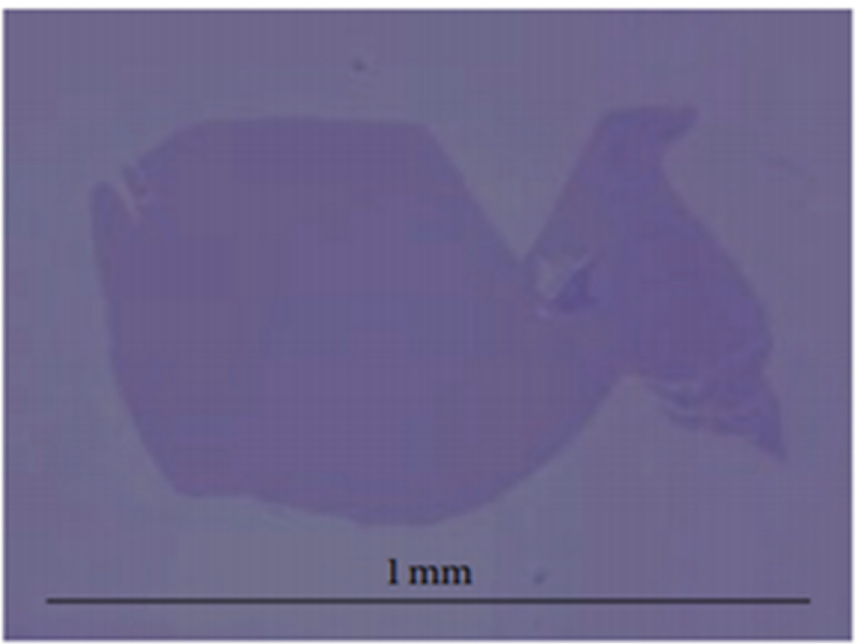
Figure 12. Single layered graphene synthesised by mechanical exfoliation on Si/SiO 2 [102].